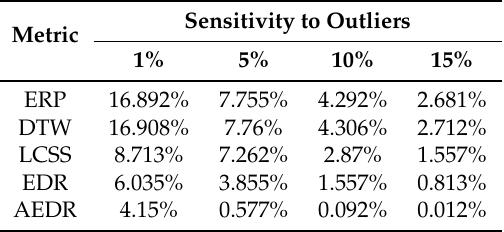
Table 1. Sensitivity to outliers for different measurement